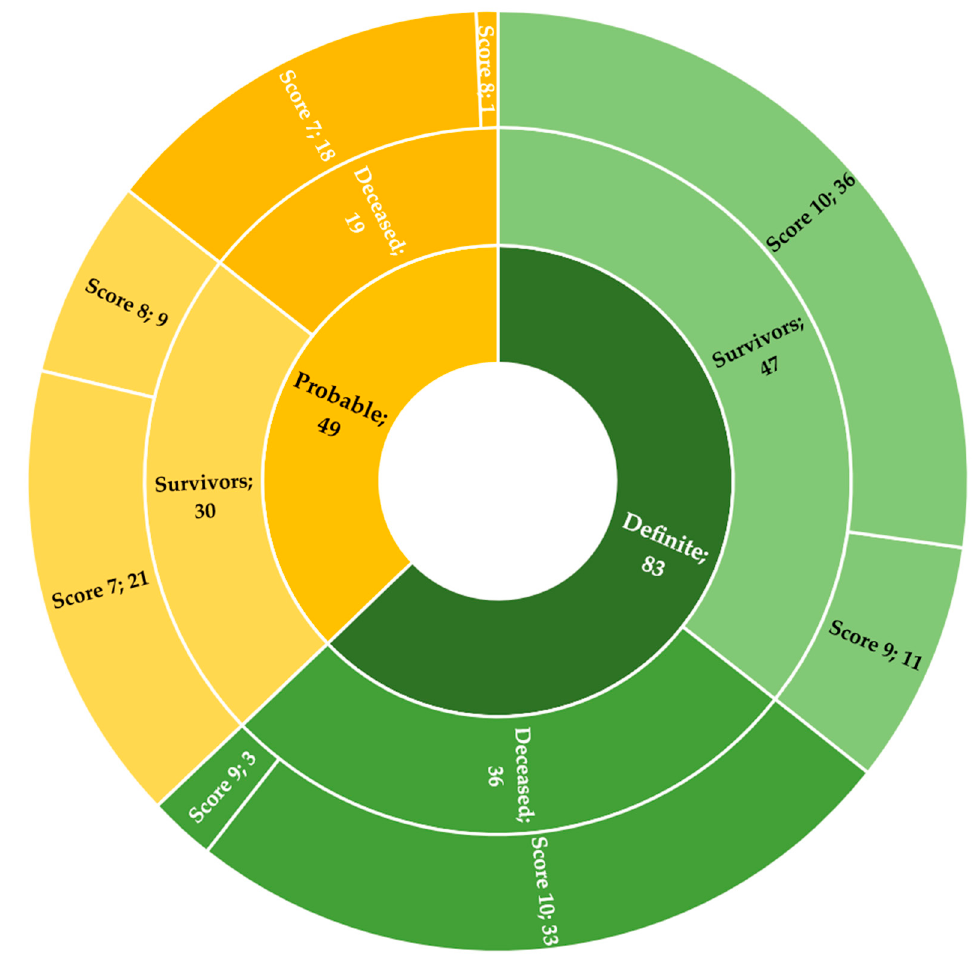
Figure 5. Data on the application of the Naranjo Adverse Drug Reaction Probability Scale.